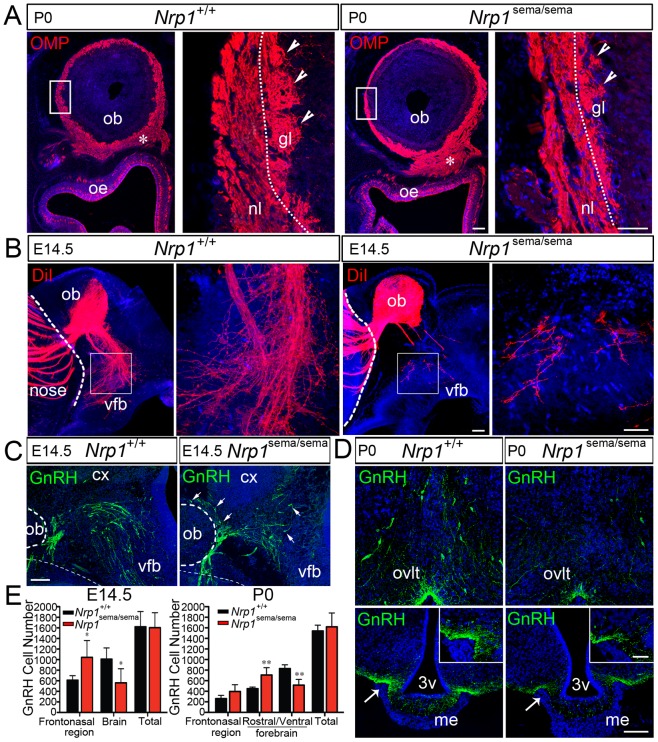
Defects in olfactory and vomeronasal axons, and GnRH cell migration in Nrp1
sema/sema mutant mice.(A) Coronal sections of the right olfactory epithelium (oe) and olfactory bulb (ob) regions (left panels), and detail of the olfactory bulb showing the olfactory nerve layer (nl) and glomerular layer (gl) (right panels) in Nrp1
+/+ and Nrp1
sema/sema newborn (P0) mice. Axons of the olfactory receptor neurons were immunostained (red) using an antibody directed against the olfactory marker protein (OMP). In the Nrp1
sema/sema mouse, the immunostaining is both enlarged below the olfactory bulb ventro-medial aspect (asterisks) and markedly reduced in the glomerular layer (arrowheads) compared to wild-type. (B) Sagittal sections of the rostral and ventral forebrain regions (left panels), and detail of the caudal branch of the vomeronasal nerve (right panels) in Nrp1
+/+ and Nrp1
sema/sema E14.5 mouse embryos. A crystal of the DiI lipophilic fluorescent dye has been placed in the vomeronasal organ lumen to anterogradely label vomeronasal axons. The vomeronasal nerve extends across the medial aspect of the olfactory bulb and projects both dorsally, to the accessory olfactory bulb, and caudally, to the ventral forebrain (vfb). In the mutant mouse, fibers in the caudal branch are scarce compared to wild-type. (C) Sagittal sections of the rostral and ventral forebrain regions at E14.5, immunostained for GnRH (green). Note the abnormal distribution of GnRH-immunoreactive cells in the Nrp1
sema/sema mouse (arrows). (D) Coronal sections of the preoptic region (upper panels) showing GnRH neuroendocrine cells (green) and their projections in the median eminence (me, arrows) (lower panels) in Nrp1
+/+ and Nrp1
sema/sema newborn (P0) mice. The immunostaining is reduced in the Nrp1
sema/sema mouse. (E) Quantitative analysis (mean ± s.d.) of GnRH cell distributions in Nrp1
+/+ and Nrp1
sema/sema mice at E14.5 and P0. * and ** denote statistically significant differences between genotypes in the indicated head regions (two-way ANOVA followed by Tukey's range test) with p<0.05 and p<0.01, respectively. Note that the total numbers of GnRH cells are not statistically different between Nrp1
+/+ and Nrp1
sema/sema mice at E14.5 or P0 (Student's t-test, p>0.05). Other abbreviations: cx, cerebral cortex; ovlt, organum vasculosum of lamina terminalis; 3v, third ventricle. Scale bars: 100 µm (50 µm in inset).